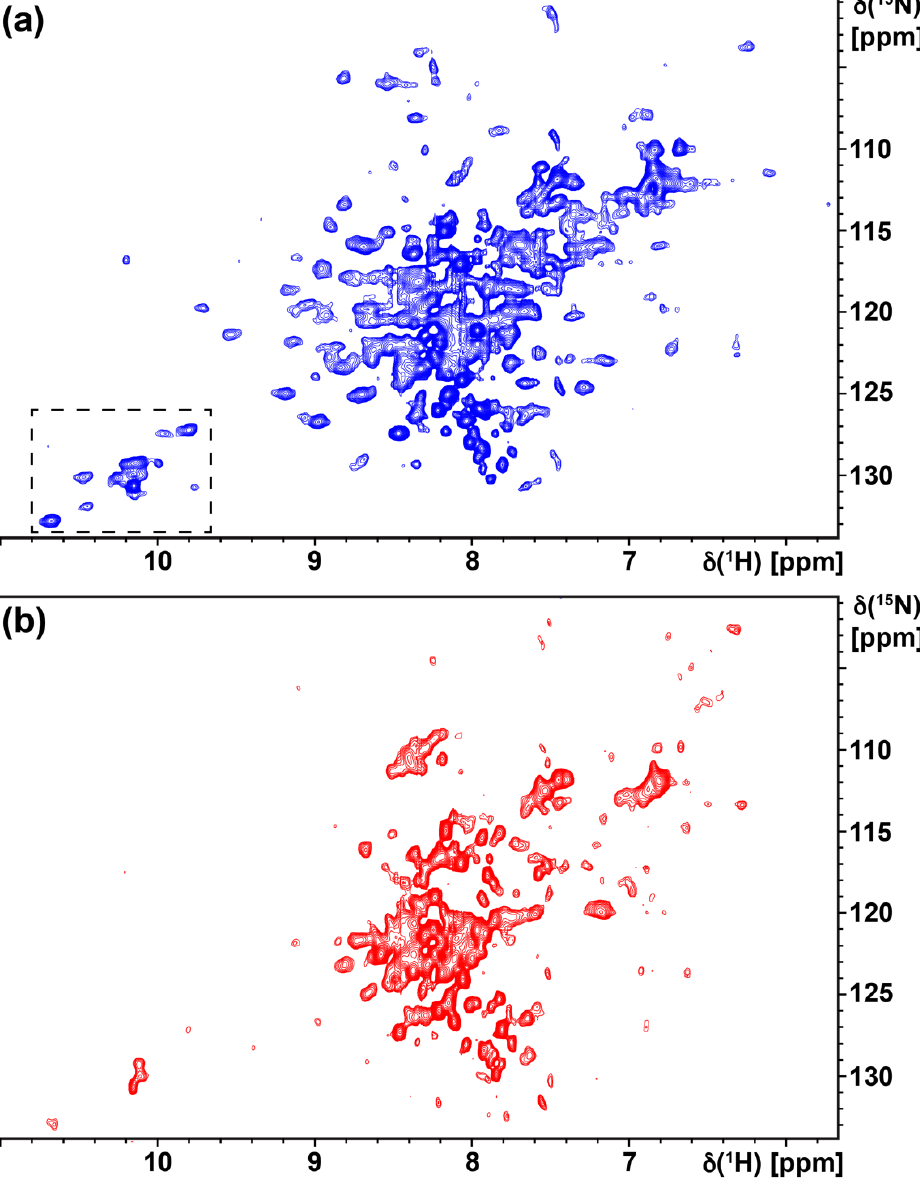
Figure 5. Two-dimensional [ 15 N, 1 H]-TROSY correlation spectra are shown of [u- 15 N] H 1 R in complex with ( a ) the antagonist doxepin and ( b ) the agonist histamine. The dashed box in panel a represents the tryptophan indole region, which is shown on an expanded scale in Figure 6. Both spectra were recorded with ~300 µM H 1 R at a 1 H NMR frequency of 800 MHz and experimental temperature of 42 °C for a total acquisition time of ~22 h per experiment.